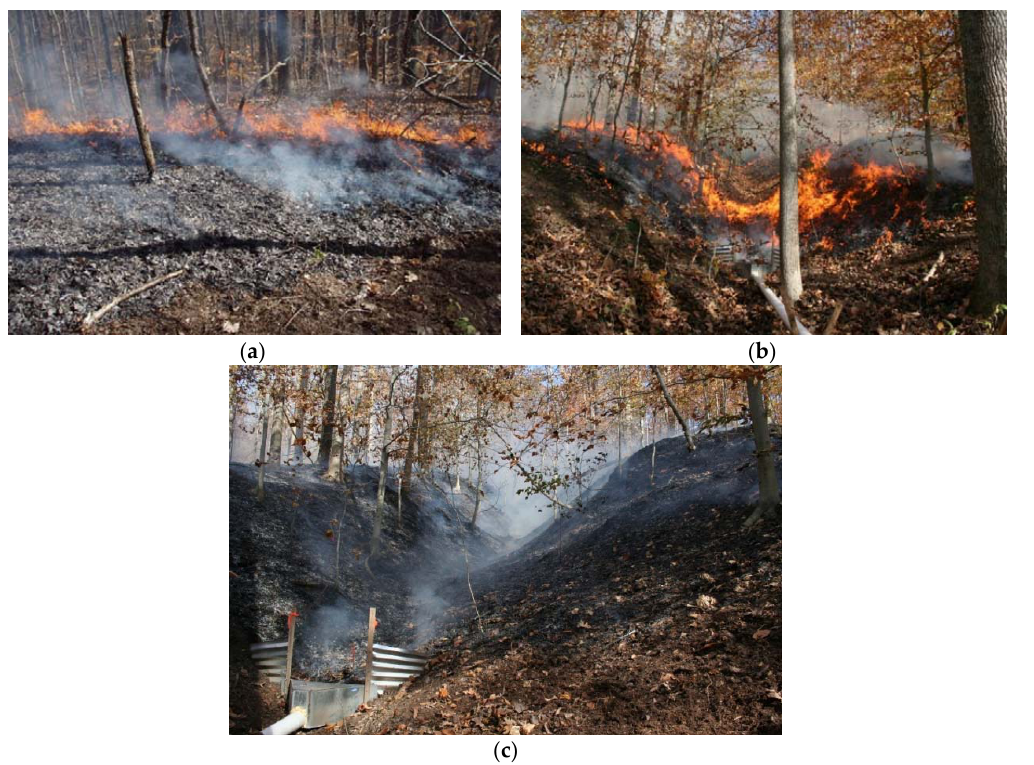
Figure 3. Example of how the backing fire was used to improve the fire line before continuing the ignition process by lighting the ring ‐ head fire. Photographs showing the completion of the ring ‐ head fire ignition sequence in watershed 10 ( a , b ). Photograph showing the completion of the prescribed burn treatment in Watershed 10 ( c ). Table 2. On ‐ site weather conditions during the prescribed burn on 6 November 2009 at Trail of Tears State Forest, IL.